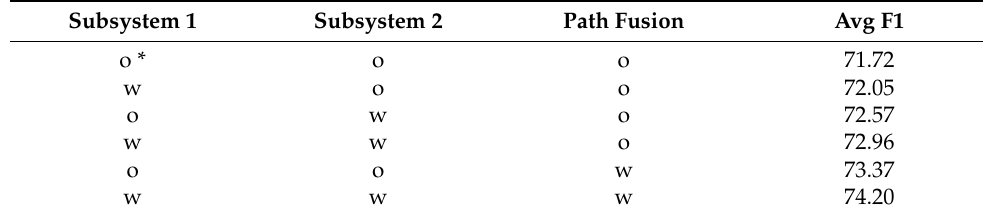
Table 4. The evaluation of the relation score in subsystems.